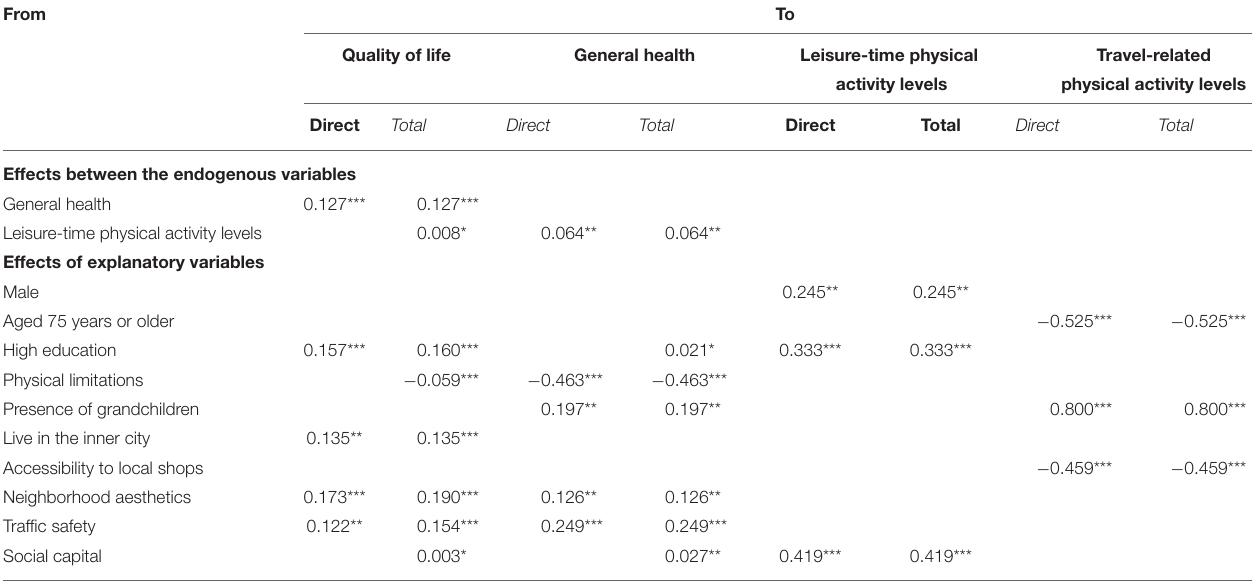
TABLE 3 | Path analysis model estimates (standardized effects).